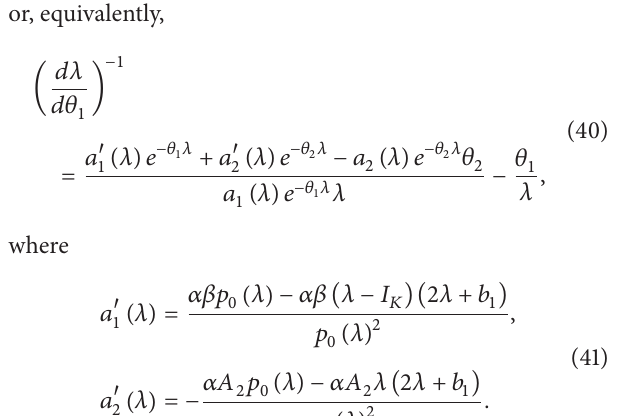
Figure 6: Crossing